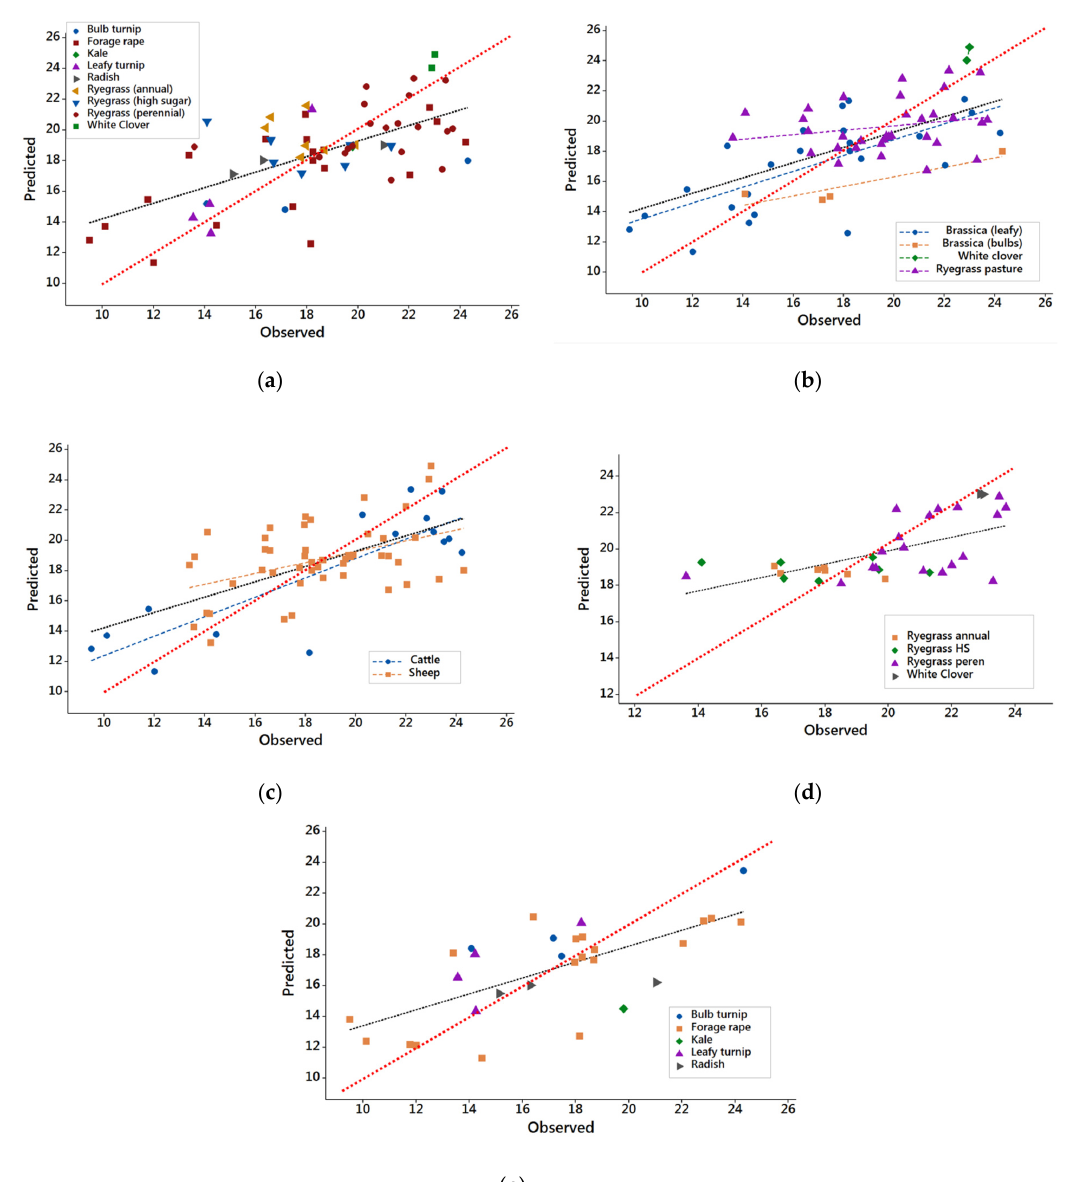
Figure 2. Scatterplots of the observed methane yields and methane yields predicted from near- infrared reflectance spectra for samples in expanded database DB2. The red dotted line in all plots is the line predicted = observed. The black dotted line in plots ( a – c ) represents the regression predicted = 9.17 + 0.506 (observed); adjusted R 2 = 0.40; both the intercept and slope are significantly different from zero ( p < 0.001). ( a ) Scatterplot from all samples. ( b ) Scatterplot according to feed type, for samples in expanded database DB2. The blue, orange, green and purple dotted lines represent the regression lines for leafy brassicas, brassica bulbs, white clover and ryegrass pasture, respectively. Only the regression line for leafy brassicas is significantly different from zero ( p < 0.001). ( c ) Scatterplot according to animal species. The blue and orange dotted lines represent the regression lines for cattle and sheep, respectively. Both regression lines are significantly different from zero ( p < 0.01). ( d ) Scatterplot from ryegrass samples. The black dotted line represents the regression predicted = 12.53 + 0.369 (observed); adjusted R 2 = 0.34; both the intercept and slope are significantly different from zero ( p < 0.001). ( e ) Scatterplot from brassica samples. The black dotted line represents the regression predicted = 8.21 + 0.518 (observed); adjusted R 2 = 0.44; both the intercept and slope are significantly different from zero ( p <